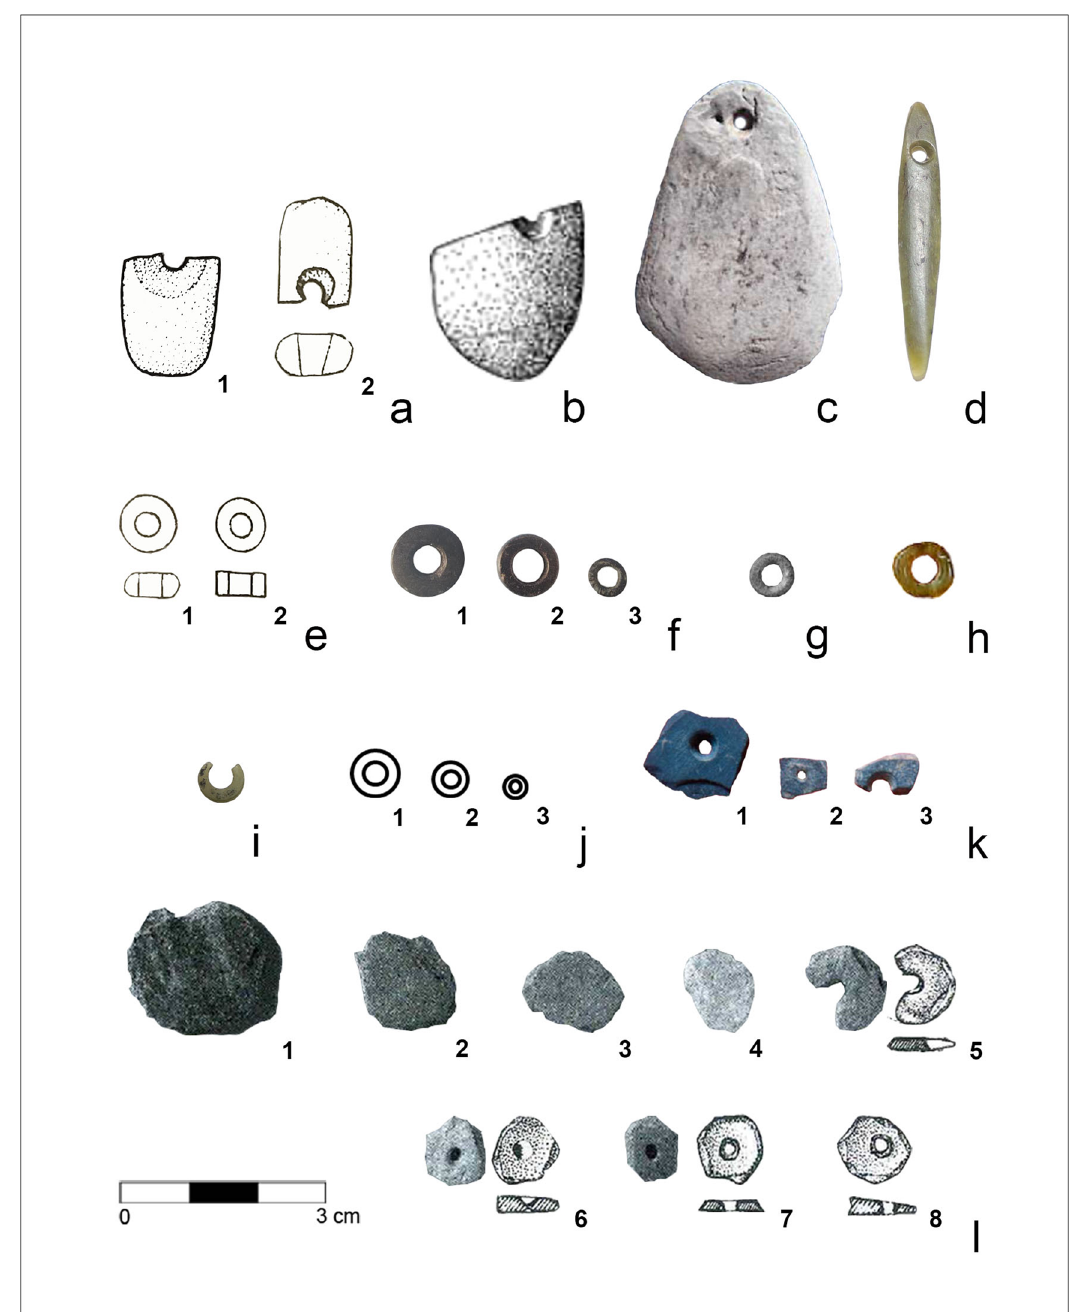
Figure 4: Selection of Italian early Neolithic stone pendants and shaped beads. ( a ) Arene Candide Cave ( Traversone, 1999 ) ; ( b ) Torre Sabea ( Radi, 2003 ) ; ( c ) Sammardenchia ( D ’ Amico, 1998 ) ; ( d ) Colle Santo Stefano ( Petrinelli Pannocchia & Vassanelli, 2016 ) ; ( e ) Arene Candide Cave ( Traversone, 1999 ) ; ( f ) Cala Giovanna Piano - Pianosa Island ( Bisconti & Zamagni, 2007 ) ; ( g ) Mora Cavorso Cave ( Silvestri et al., 2020 ) ; ( h ) Ripabianca di Monterado ( Lollini, 1991 ) ; ( i ) Pollera Cave ( photograph by A. Vassanelli ) ; ( j ) La Marmotta ( Micheli, 2003 ) ; ( k ) Favella della Corte ( Micheli, 2009 ) ; and ( l ) Le Secche - Giglio Island ( Brandaglia, 1987 ) . Elaboration by A.